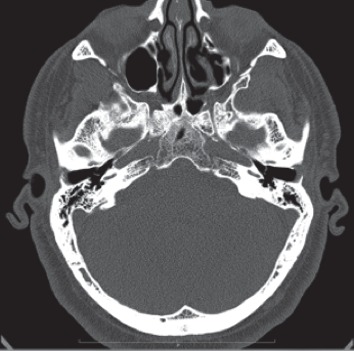
The computed tomography (CT) did not show bone alterations or changes suggestive of malignant external otitis.